Question: Draft a figure caption describing what is shown.
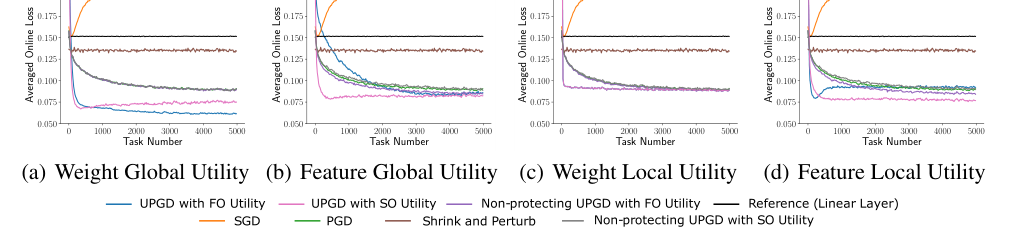
Answer: Performance of UPGD on the toy problem with a changing input-index set against SGD, PGD, and S&P. First-order and second-order approximated utilities are used.